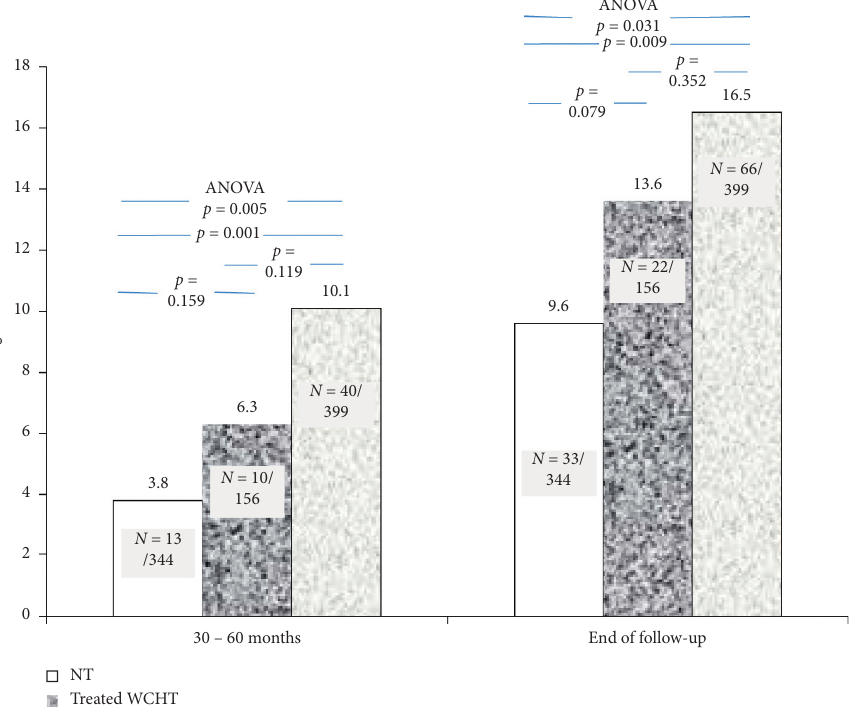
Figure 1: Cumulative incidence and rate (%) of progression to sustained hypertension (SHT) of normotensive subjects (NT) and treated and untreated WCHT subjects. In untreated WCHT, SHT occurred more frequently and earlier than NT.